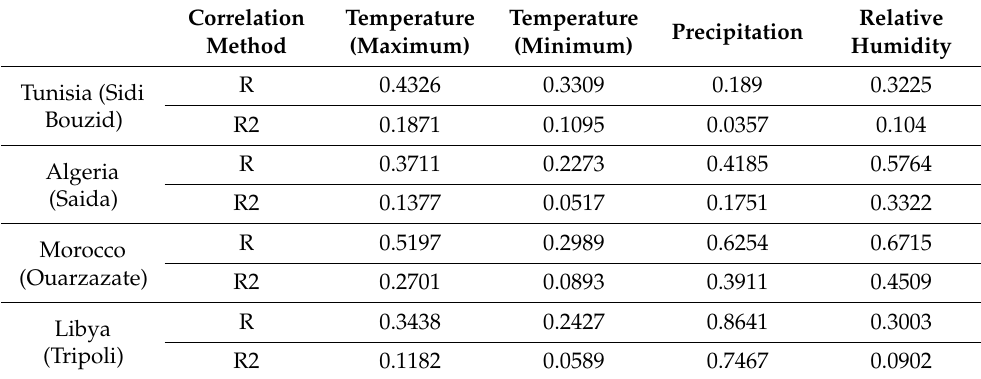
Table 3. Correlation between ZCL cases and climatic parameters in the studied countries. Relative Correlation Temperature Temperature Precipitation Method (Maximum) (Minimum)